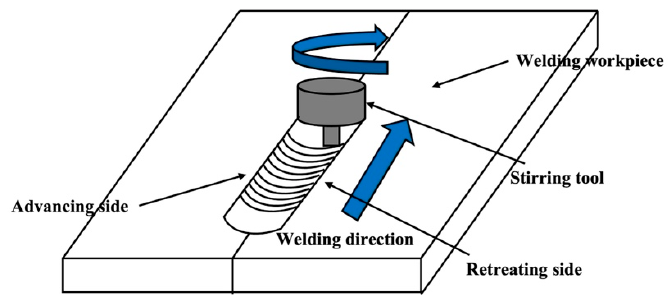
Figure 1. Friction stir welding principle diagram.